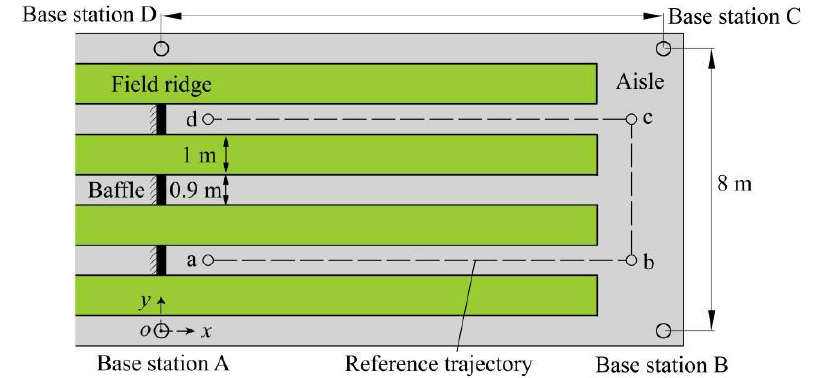
Figure 3 . Schematic diagram of greenhouse experiment site. Figure 3. Schematic diagram of greenhouse experiment